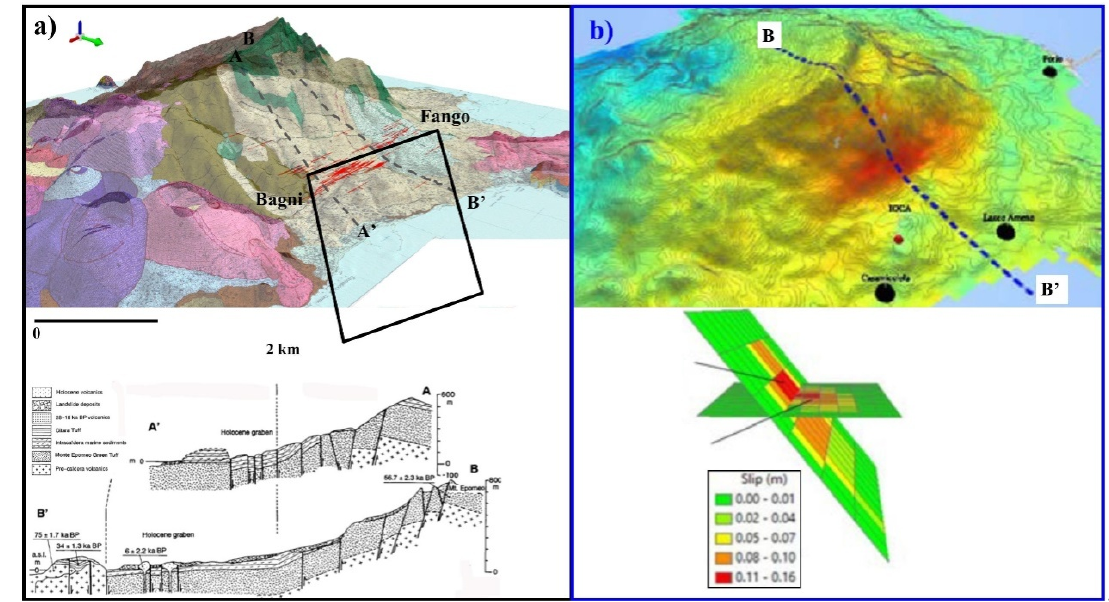
Figure 7. Comparison between the observed (on the left) and InSar modeled deformation due to the 2017 Casamicciola earthquake; ( a ) geological map of [16] overlapped on the 3D terrain model of Ischia island; note the trace of geological sections A ′ A and B ′ B shown on the bottom [32]; the black rectangle represents the fault plane of the 2017 Casamicciola earthquake source, as defined in the present study; ( b ) on the top, InSAR surface deformations along the section B-B’ on the flank of Mt. Epomeo and on the bottom, the [70] analytic model of the 2017 Casamicciola source.